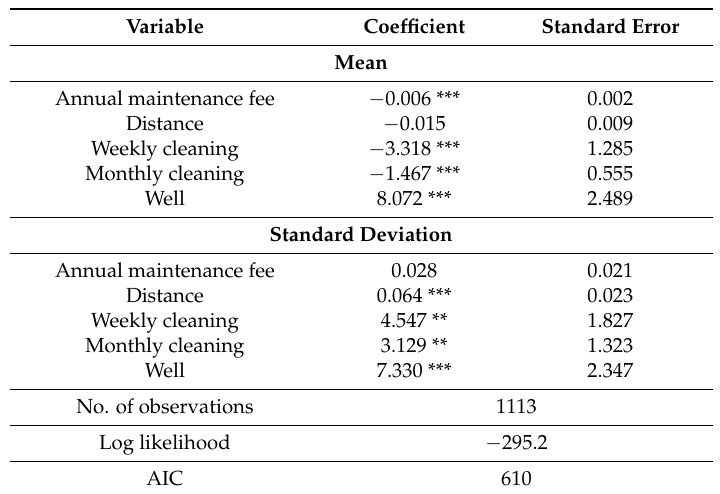
Table 5. Mixed logit